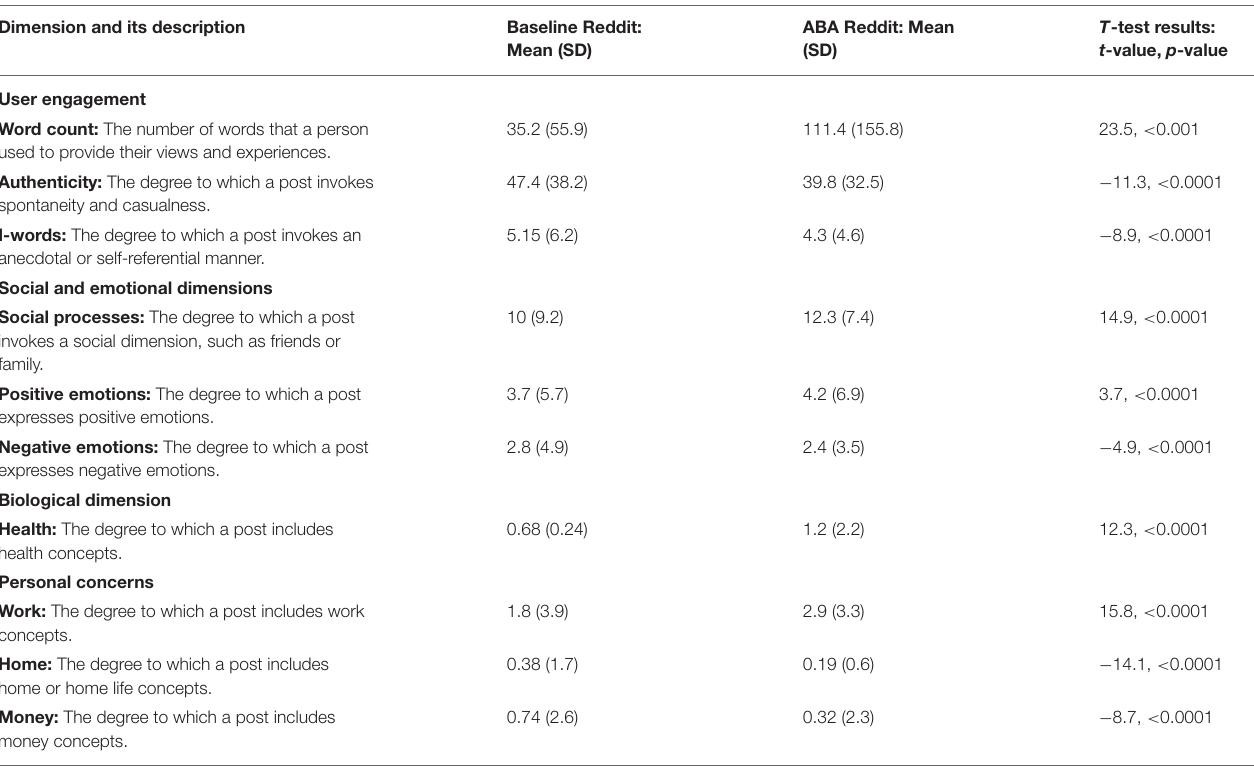
TABLE 3 | Key linguistic analyses variables for Reddit ABA conversations and the baseline Reddit posts. Dimension and its description Baseline Reddit: